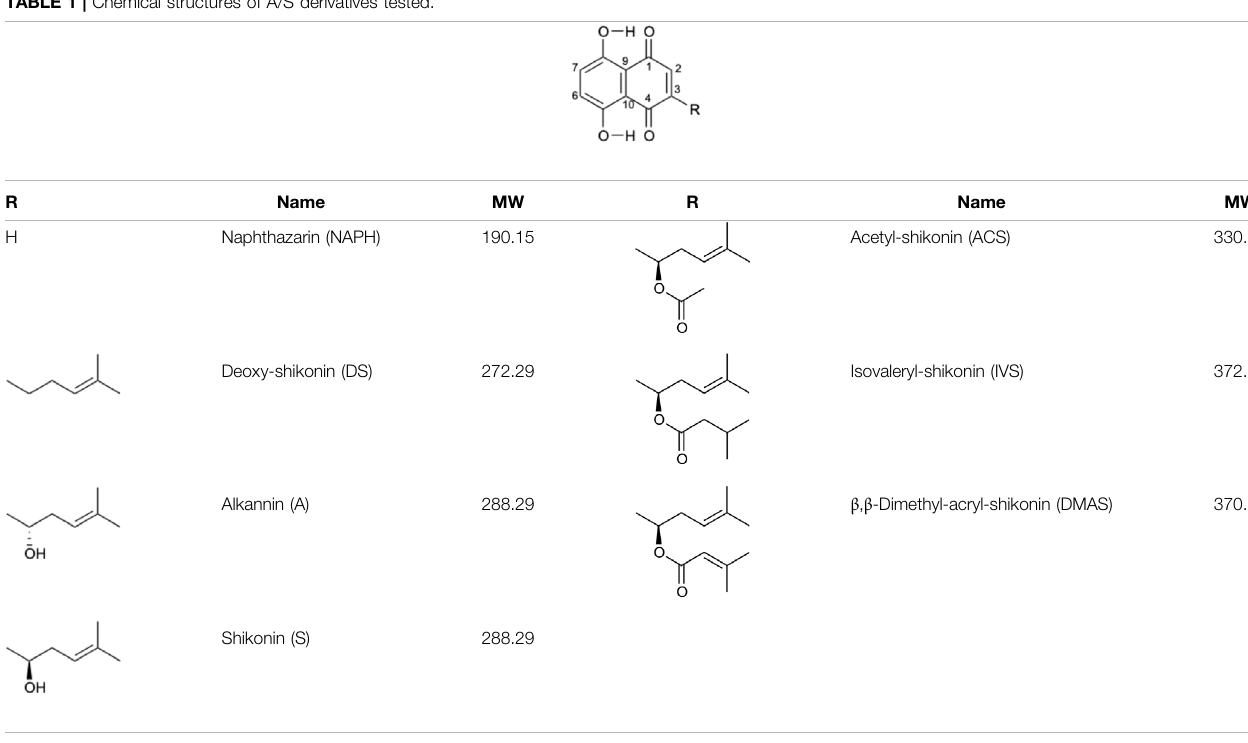
TABLE 1 | Chemical structures of A/S derivatives